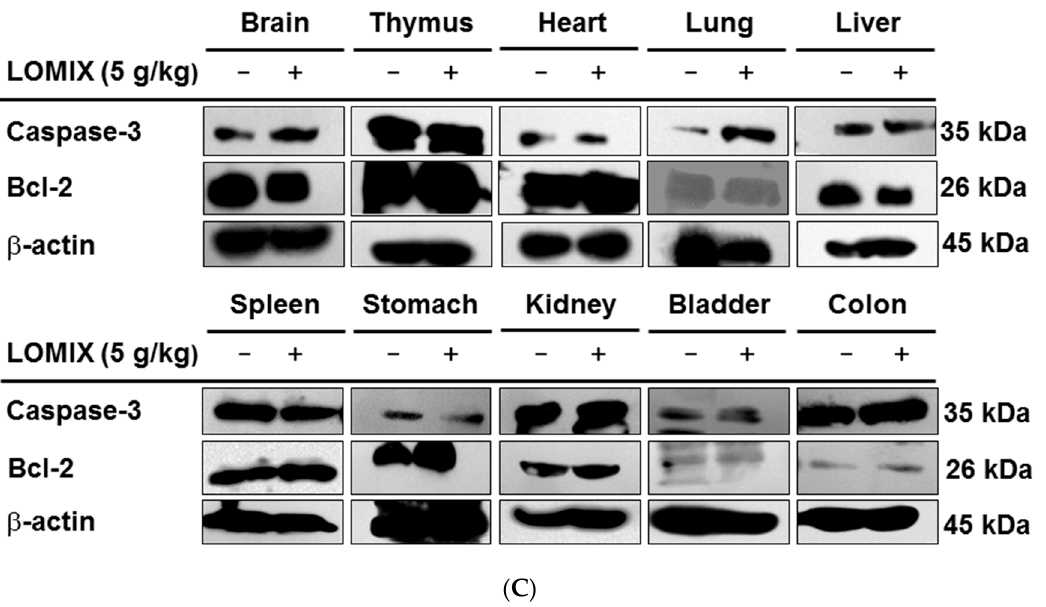
Figure 5. In vivo acute toxicity study of LOMIX. ICR mice received a single dose of LOMIX (5 g/kg) orally, and organs (brain, thymus, heart, lung, liver, spleen, stomach, kidney, bladder, and colon) were excised after 24 h. ( A ) Organs were photographed, and ( B ) the weight of the organs was measured using a scale. ( C ) Caspase-3 and Bcl-2 in whole lysates of each organ were detected by Western blot analysis, and β -actin was used as an internal control.